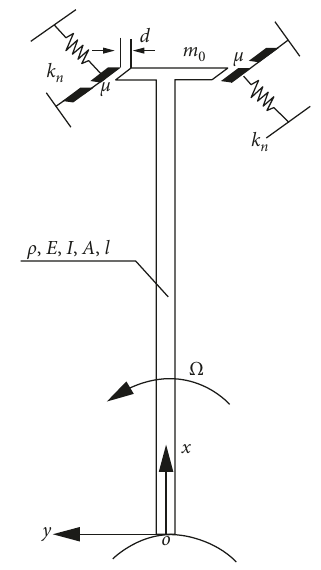
Figure 3: The analytical model of the shrouded